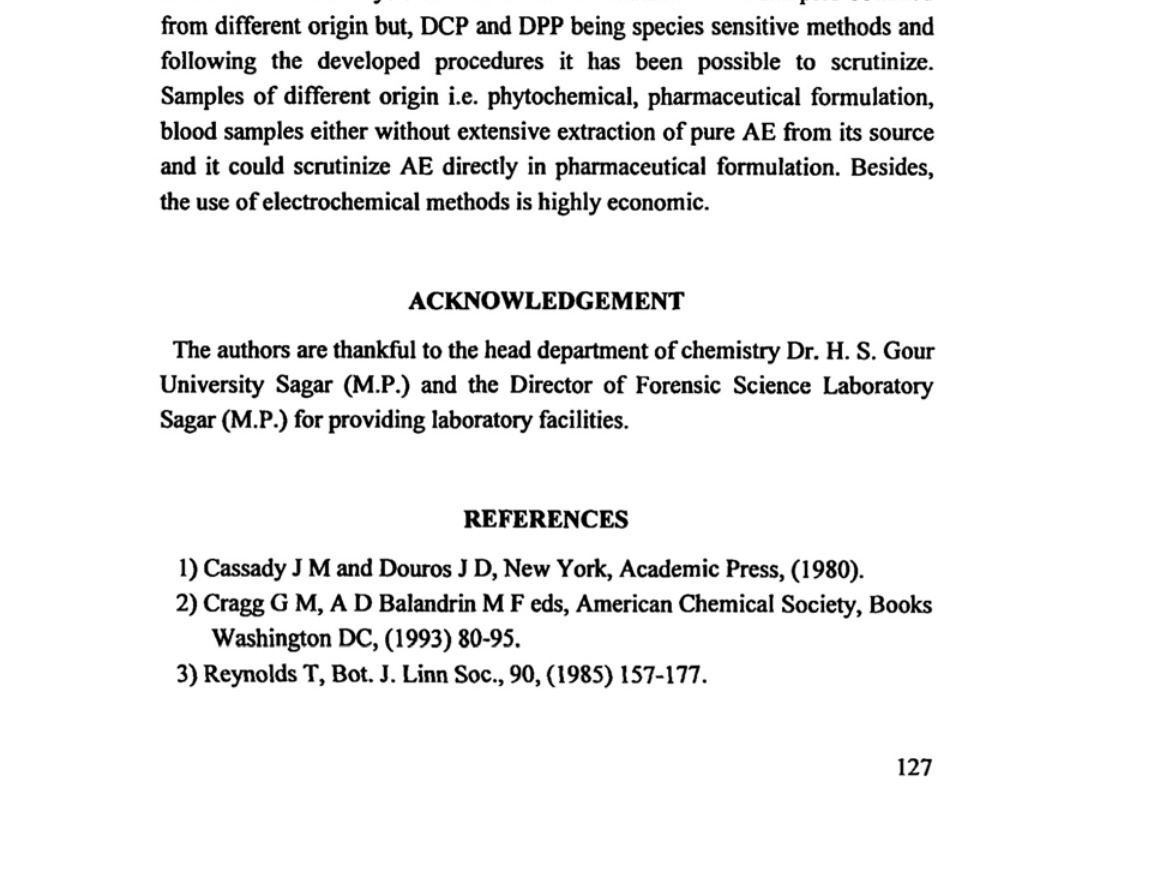
Fig. xi: HPLC Chromatogram for AE in human blood plasma (1000